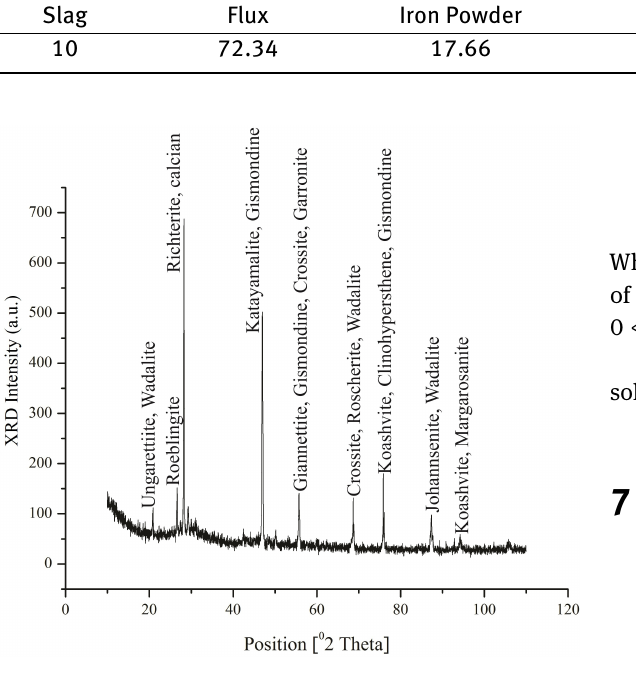
Figure 3: XRD analysis for slag sample 5